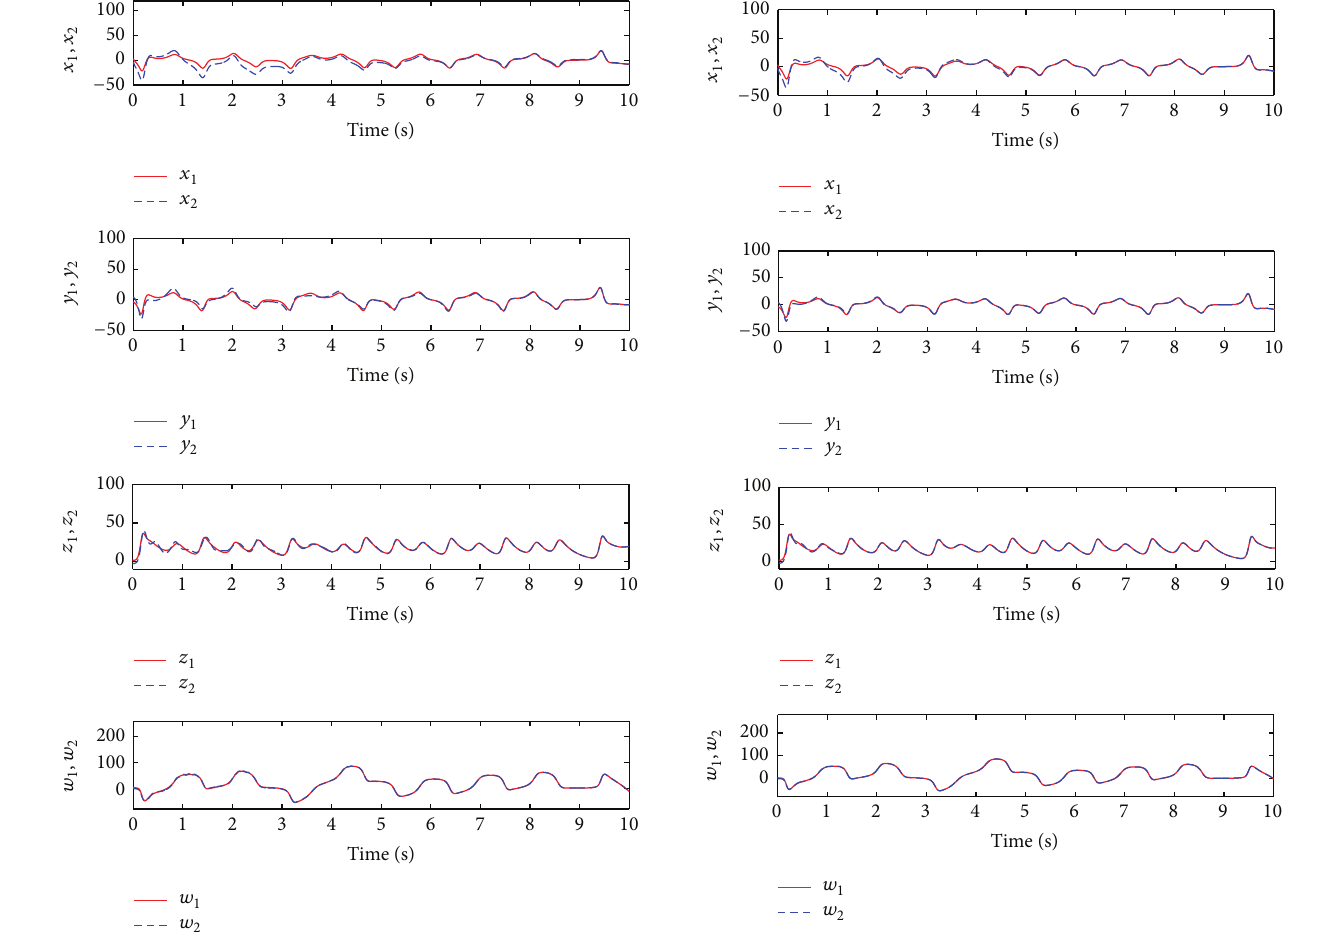
Figure 2: The states of the hyperchaotic Chen systems (5) and (6) with 𝜌 = 1 .